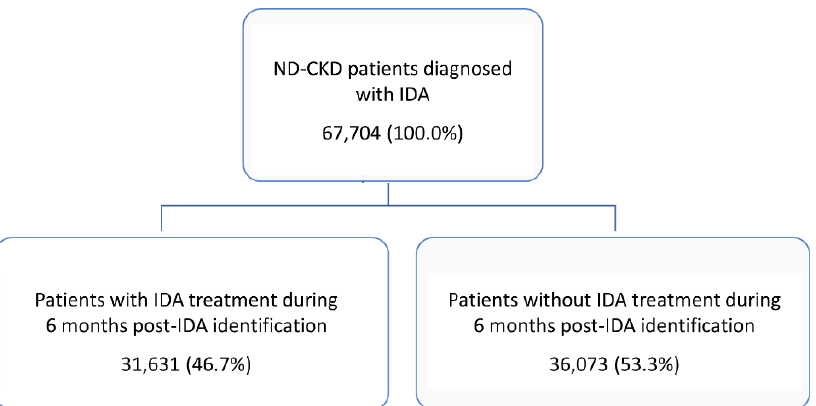
Figure 2 . Identification of the target population and divided according to the presence/absence of iron-deficiency anaemia (IDA) therapy during the 6-month period after IDA identification. ND, non-dialysis; CKD, chronic kidney disease.